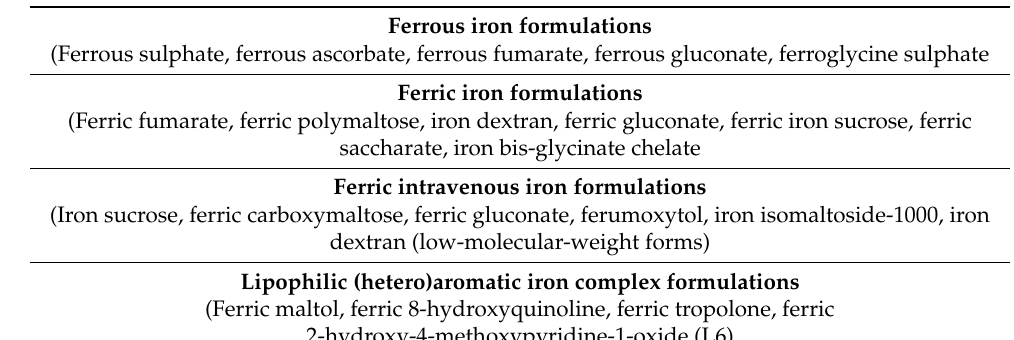
Table 3. Examples of iron complexes used for the treatment of iron deficiency